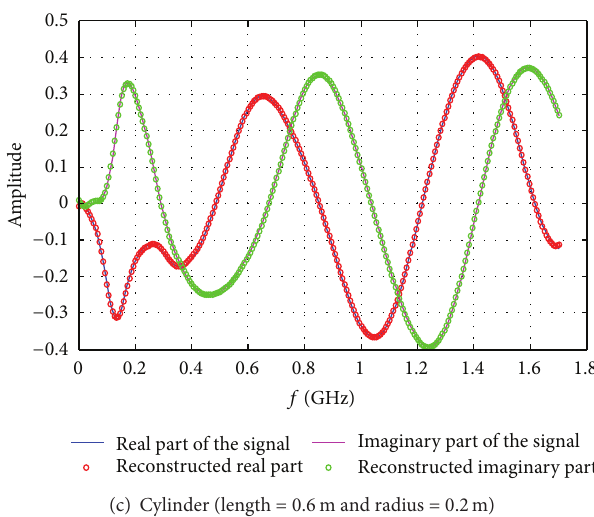
Figure 4: Simulated signal compared with reconstructed signal by MPMFD for a sphere (radius = 0.3 m).